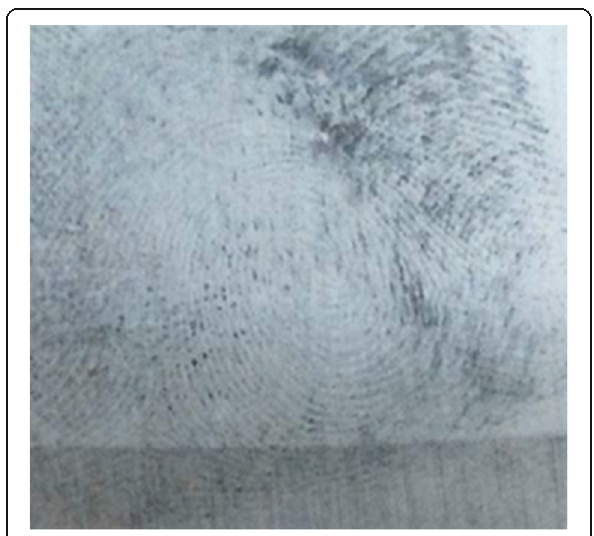
Fig. 3 Developed fingerprint using black powder on glass surface after submersion in sea water for 1 day. (Score 3)